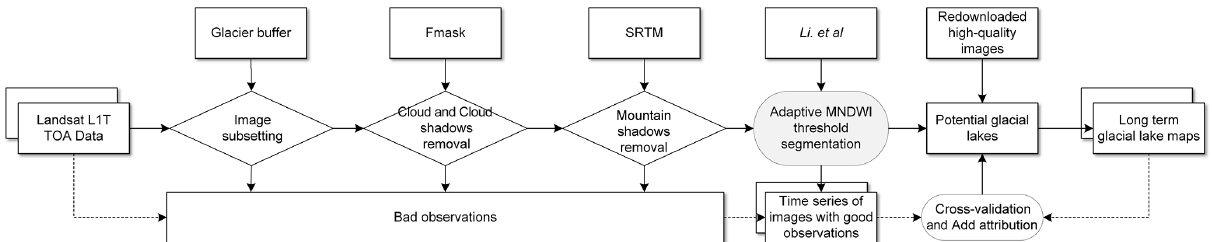
Figure 3. Diagram of the glacial-lake mapping